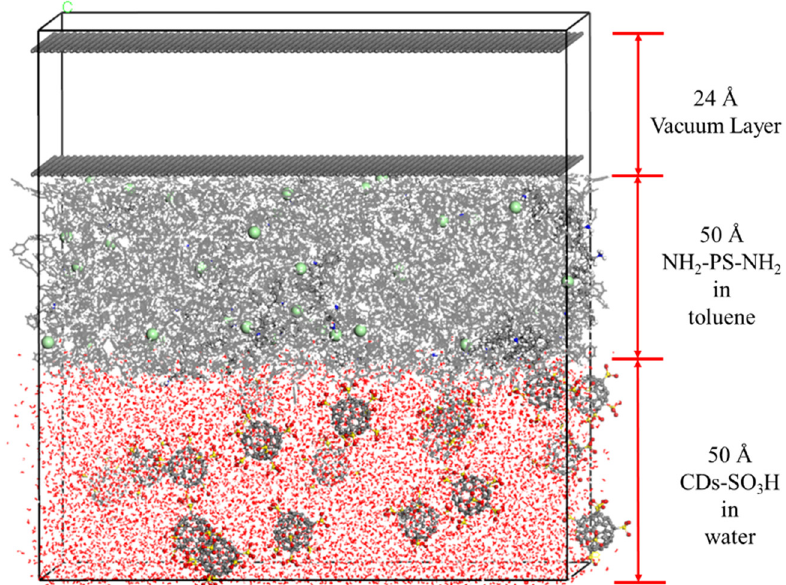
Figure 3: Model used in the MD